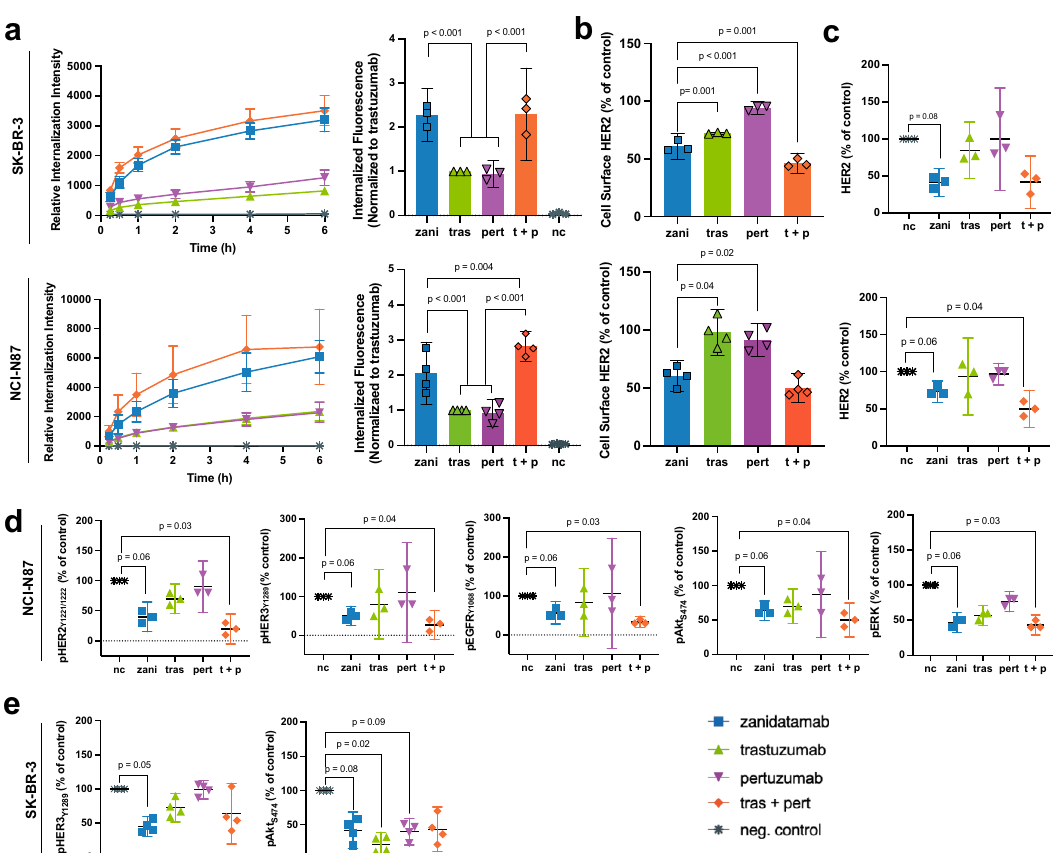
Fig. 5 | Zanidatamab promotes Ab internalization, surface and total HER2 downregulation and signal inhibition in SK-BR-3 and NCI-N87 cells. a Zanidatamabshowed increased receptor-mediated internalization compared to trastuzumab or pertuzumab (15min to 6h), measured by high content micro- scopy ( n =3 independent experiments). (Right) Zanidatamab conferred sig- ni fi cantly greater receptor-mediated internalization compared to trastuzumab or pertuzumab (adjusted p <0.001) in SK-BR-3 cells or NCI-N87 cells (24h), mea- sured by fl ow cytometry ( n = 3 SK-BR-3 or n =4 NCI-N87 independent experi- ments). A two-way ANOVA controlling for experiment with Bonferroni correction formultiple comparisons was performed, data normalized to trastuzumab, df = 3 for ANOVA and df = 4 for t -tests. b Zanidatamab showed signi fi cantly greater surface HER2 downregulation compared to trastuzumab ( p =0.001) and pertu- zumab ( p <0.001) in SK-BR-3 cells and compared to trastuzumab ( p =0.04) and pertuzumab ( p =0.02) in NCI-N87 cells, evaluated by fl ow cytometry. Tras + pert mediated signi fi cantly greater HER2 downregulation compared to zanidatamab